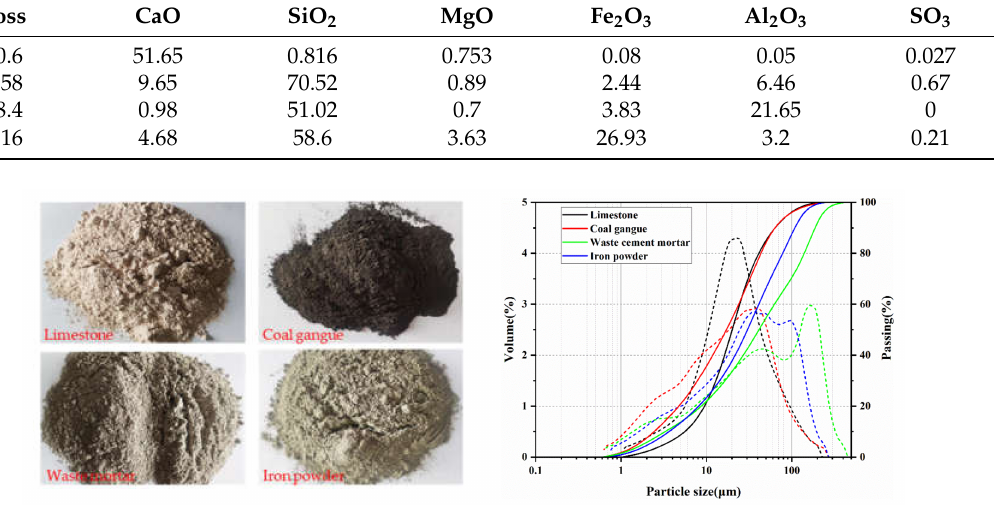
Figure 1. Raw materials and the particle size distribution of raw materials. (Solid line: pass rate Dashed line: volume